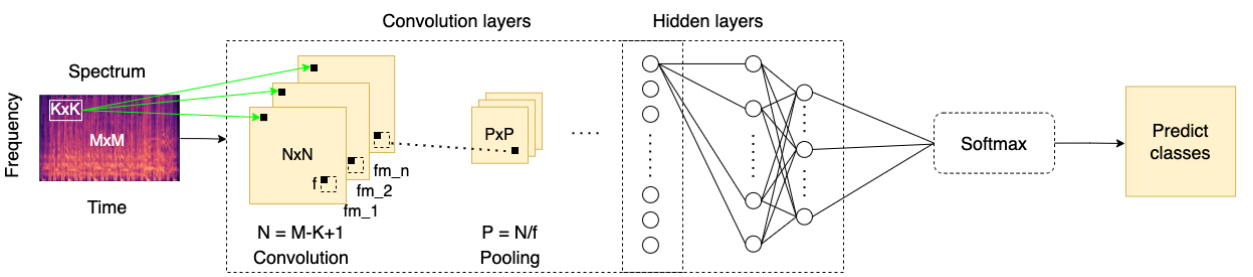
Figure 2. Flowchart of CNN based music emotion classification. Start from original music files, then through convolutional layers and hidden layers, and make predictions with a classifier softmax at the